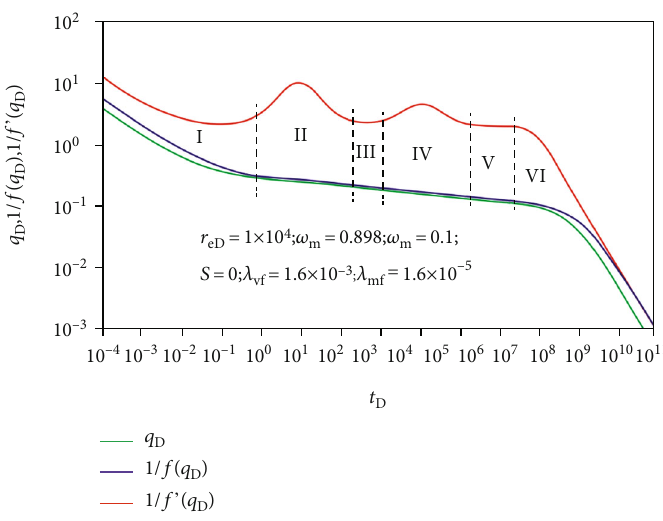
Figure 8: Type curves of rate decline for a triple-porosity reservoir.